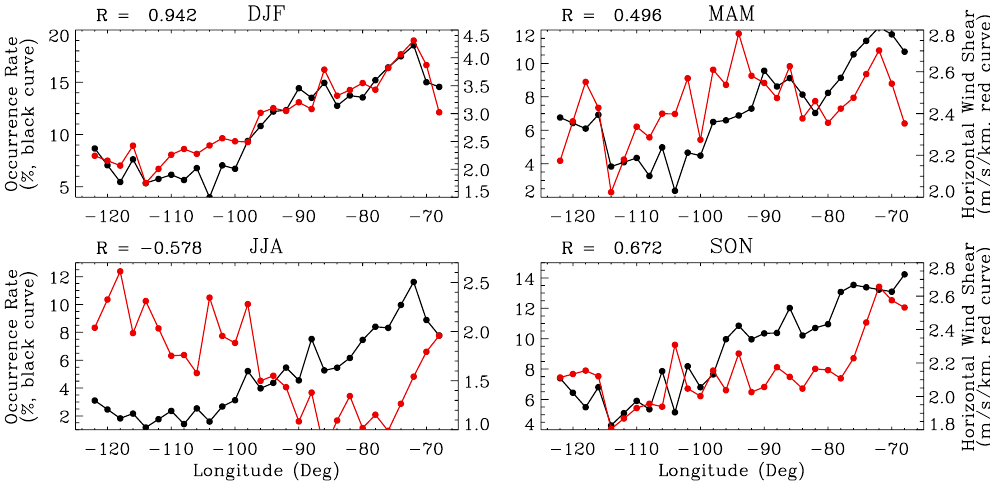
Fig. 8. Longitudinal variation of meridionally averaged occurrence rate of lower tropospheric inversions (black curve) and mean horizontal wind shear in the range of 2–5km (red curve) over 56 stations in different